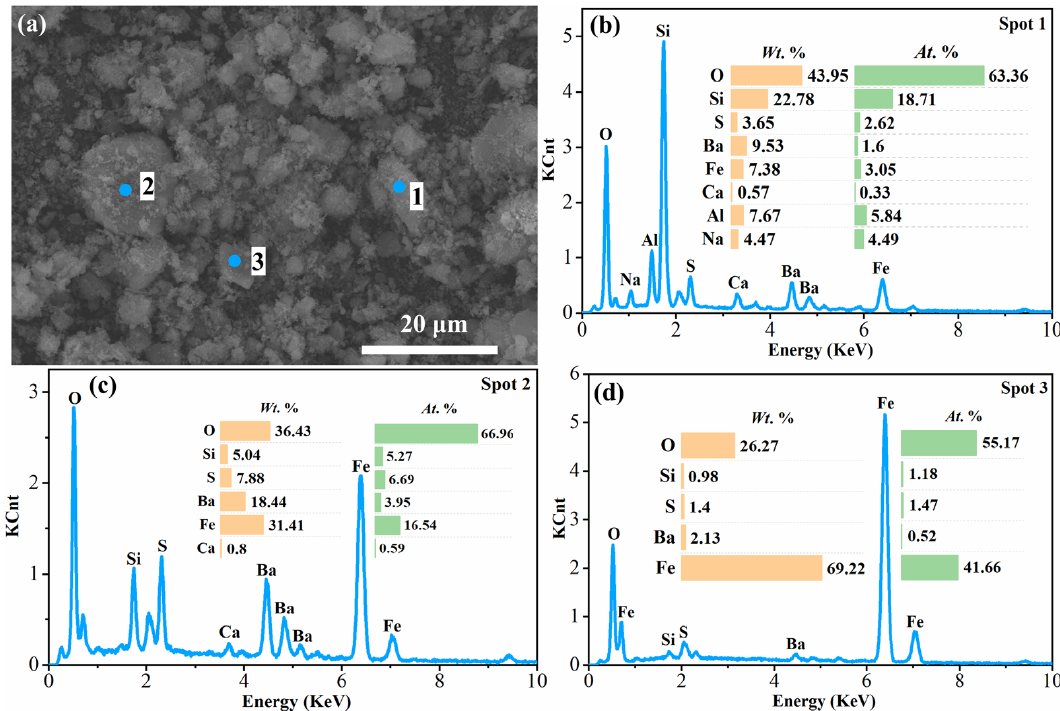
Figure 10. SEM image and EDS analysis of the acid leaching residue of 2 mol/L H 2 SO 4 at 1 min: ( a ) SEM image of the acid leaching residue; ( b ), ( c ) and ( d ) EDS analysis of Spot 1, Spot 2 and Spot 3, respectively, in Figure 10a.